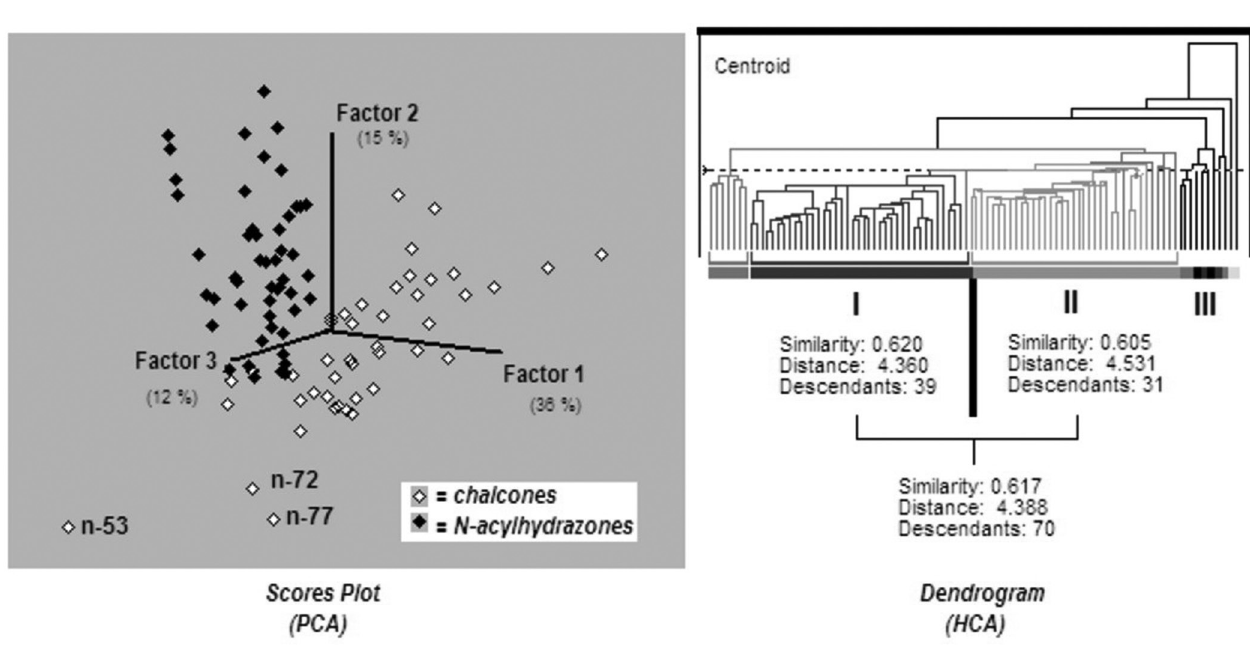
FIGURE 3 - Preliminary PCA and HCA of the investigated set of compounds.